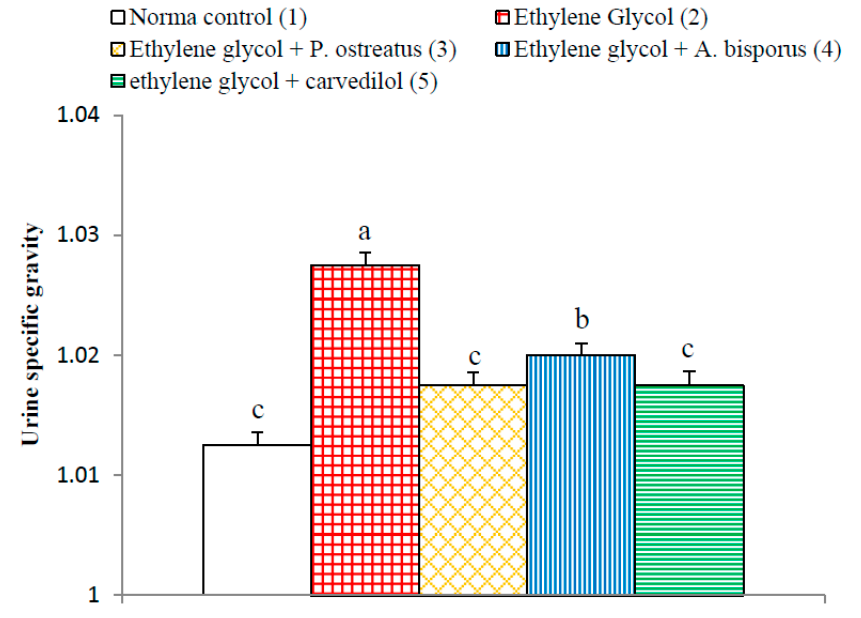
Figure 9. E ff ect of P. ostreatus and A. bisporus aqueous extracts and carvedilol on urine specific gravity in ethylene glycol-administered rats. Means which share the same letter(s) are not significantly di ff